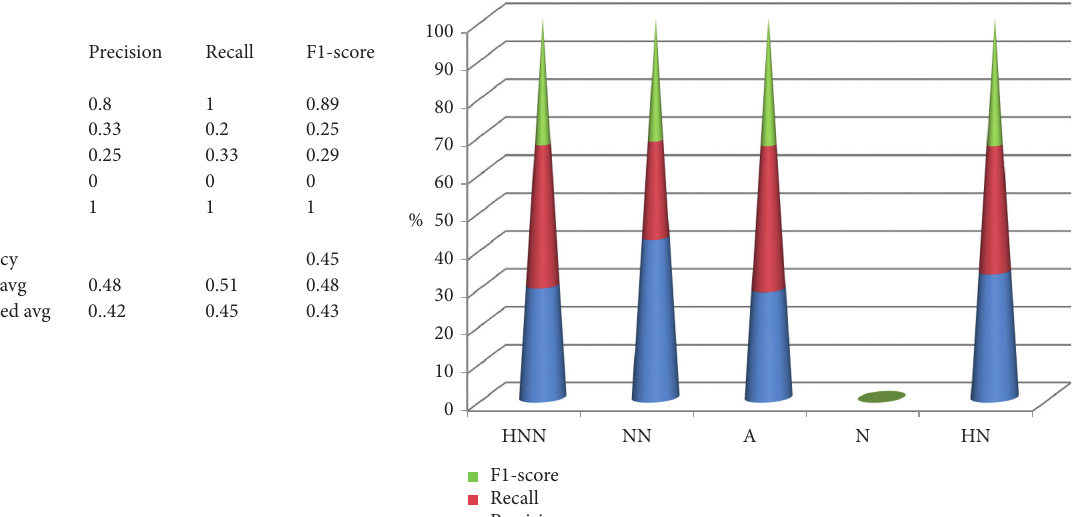
Figure 14: Accuracy report with “ k �